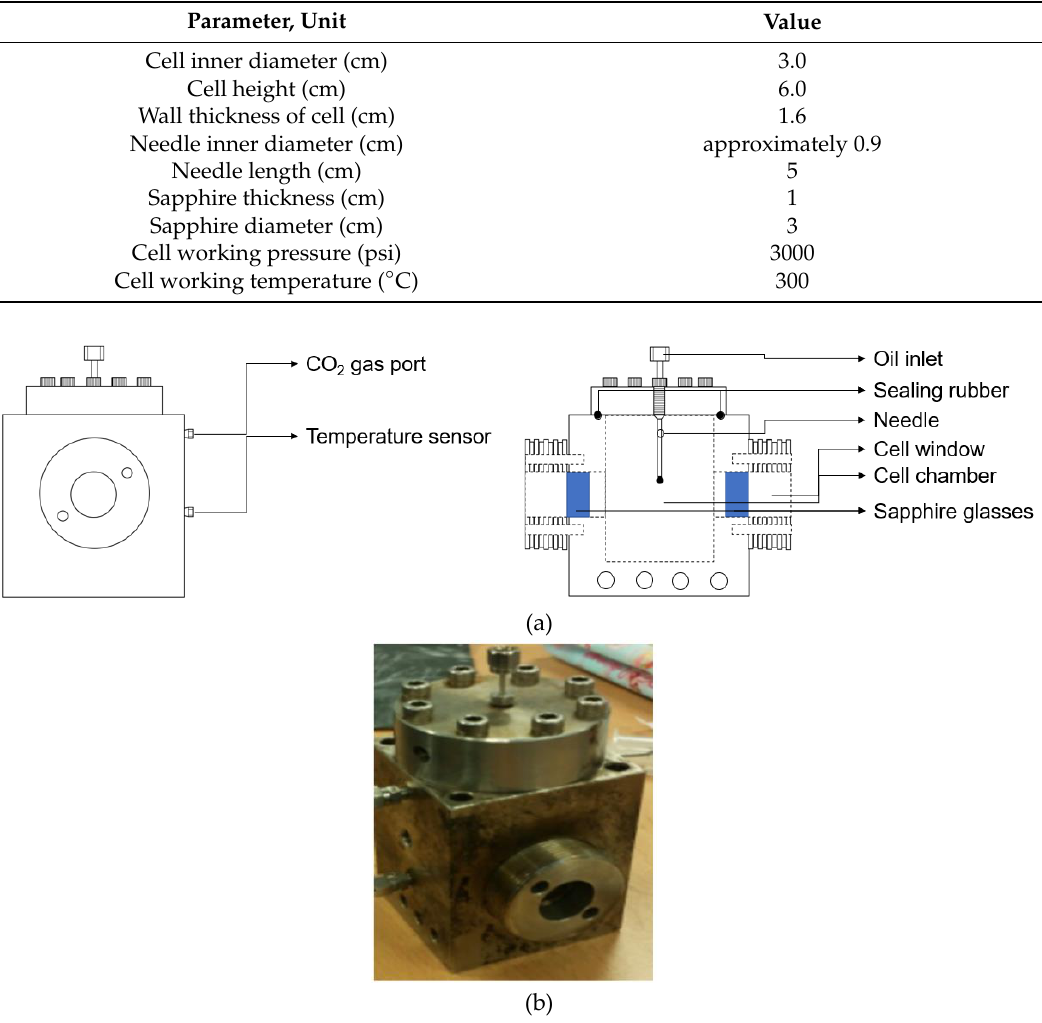
Figure 3. HPHT optical cell: (a) a schematic diagram with part details and (b) an actual equipment. ADSA measures the IFT of a pendant drop hanging at a capillary tube tip (Figure 4; Equation